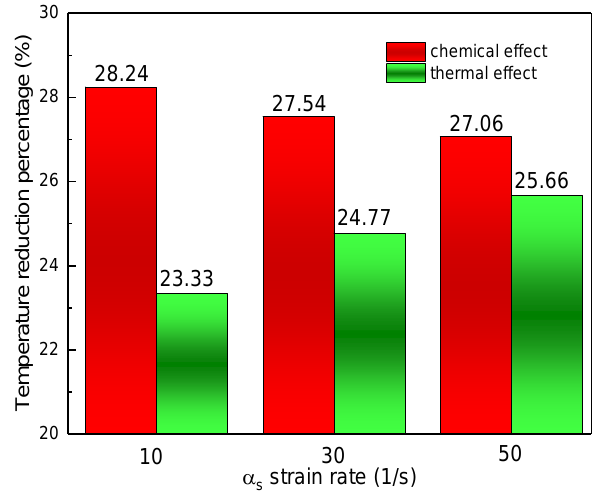
Figure 9. The comparison of 𝑅𝑃 𝑐ℎ𝑒𝑚 and 𝑅𝑃 𝑡ℎ𝑒𝑟𝑚 with different global strain rate at p = 1 atm and β = 0%, 50%.